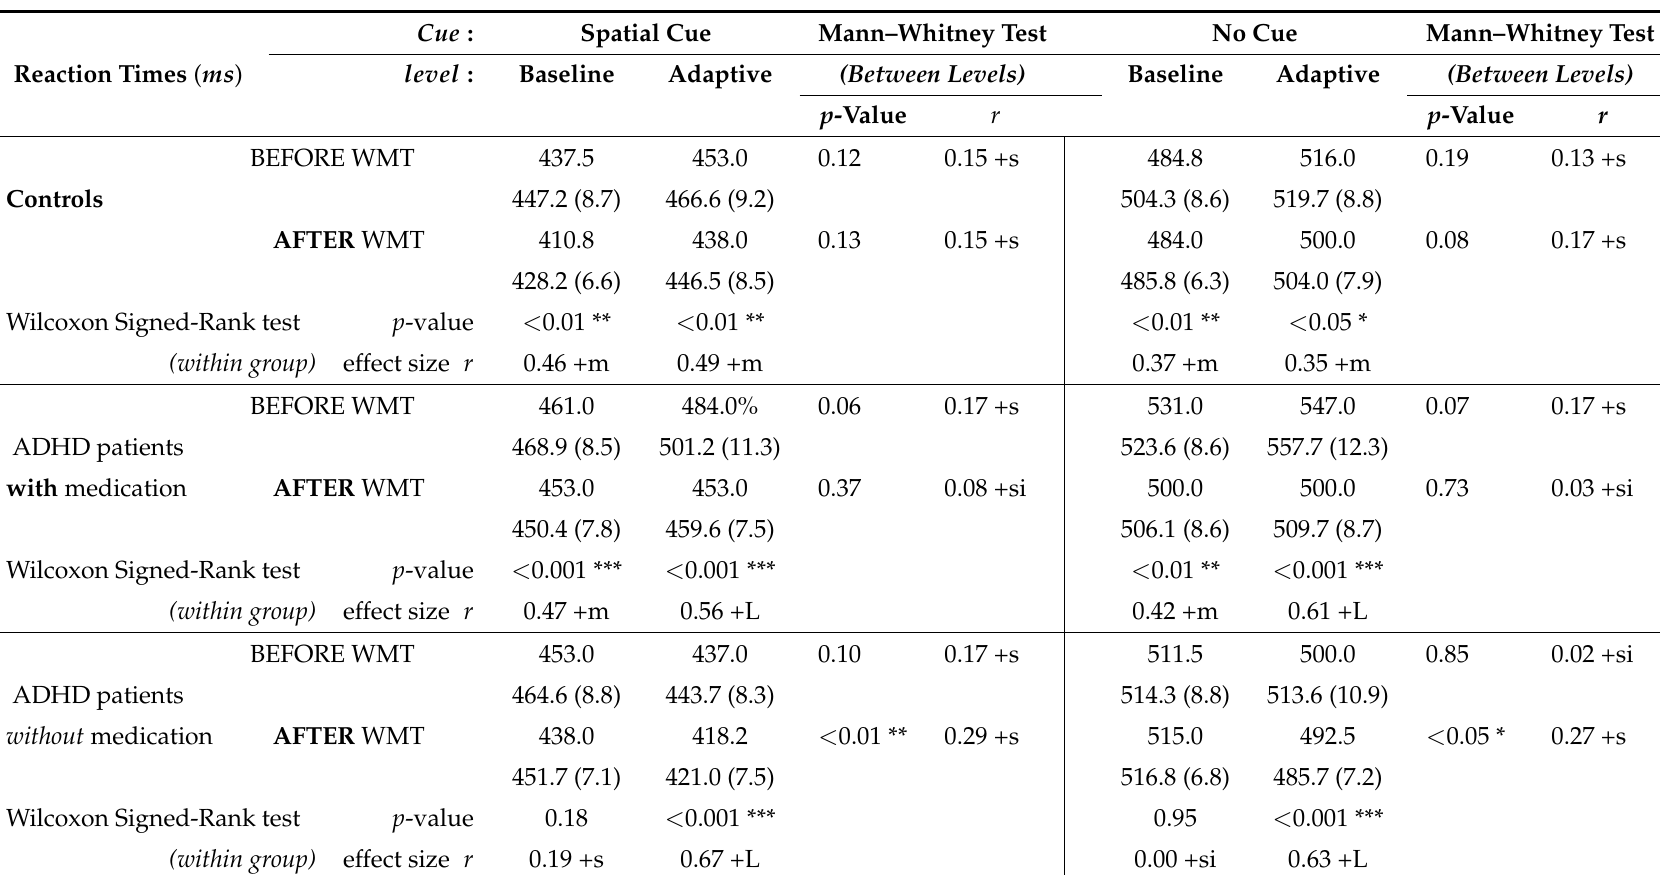
Table 4. Descriptive statistics (median, mean, and SEM) of reaction times for each group of participants and for any target type (pooled together) as a function of Spatial Cue and No Cue . Comparisons between levels of training (Mann–Whitney test) and between before and after working memory training (WMT) within each group (Wilcoxon Signed-Rank test). For each test the corresponding p -values and effect size ( r ) are reported in the